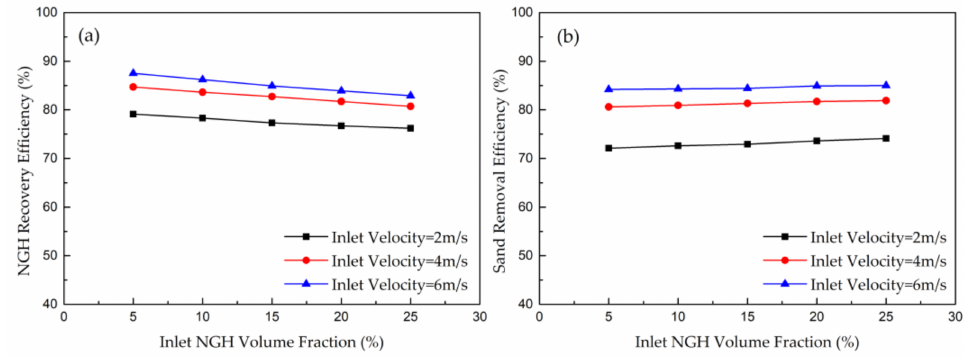
Figure 14. The relationship between inlet NGH volume fraction and separation e ffi ciency: ( a ) is for NGH, ( b ) is for